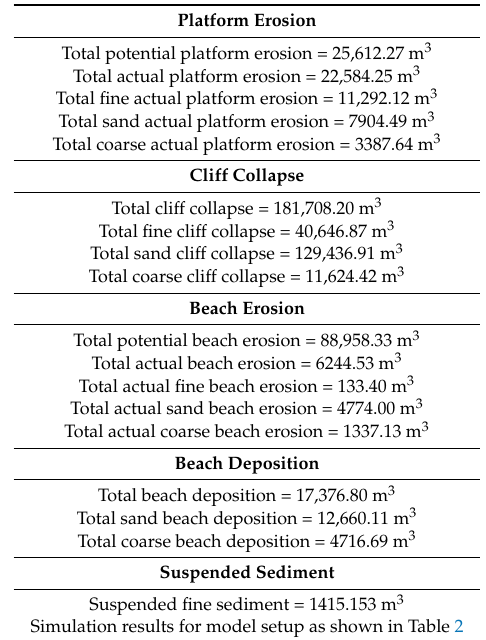
Table 3. Total accumulated annual platform erosion, cliff collapse, beach erosion, beach deposition and suspended sediment.